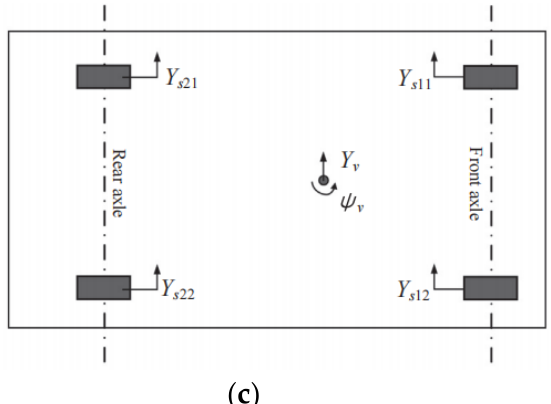
Figure 2. The high ‐ sided road truck, ( a ) elevation view, ( b ) side view, ( c ) plan view. Each rigid body in the front and rear axles of the vehicle was connected to the vehicle body through suspension units, including vertical linear elastic springs K uzi and viscous dampers C uzi , and horizontal linear elastic springs K uyi and viscous dampers C uyi . In addition, each rigid body in the front and rear axles of the vehicle was connected to the bridge deck through tire units, including vertical linear elastic springs K lzi and viscous dampers C lzi , and horizontal linear elastic springs K lyi and viscous dampers C lyi . The detailed parameters of the high ‐ sided truck can be found in [11].